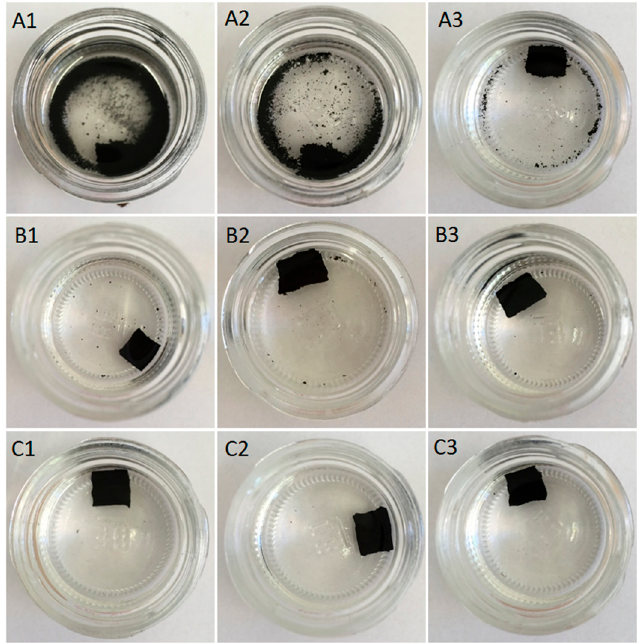
Figure 3. Samples after a few minutes of extraction in toluene: ( A1 ) GTR+TOR ‐ 140 °C; ( A2 ) GTR+TOR ‐ 160 °C; ( A3 ) GTR+TOR ‐ 180 °C; ( B1 ) GTR+EVA1 ‐ 140 °C; ( B2 ) GTR+EVA1 ‐ 160 °C; ( B3 ) GTR+EVA1 ‐ 180 °C; ( C1 ) GTR+EVA2 ‐ 140 °C, ( C2 ) GTR+EVA2 ‐ 160 °C, and ( C3 ) GTR+EVA2 ‐ 180 °C.